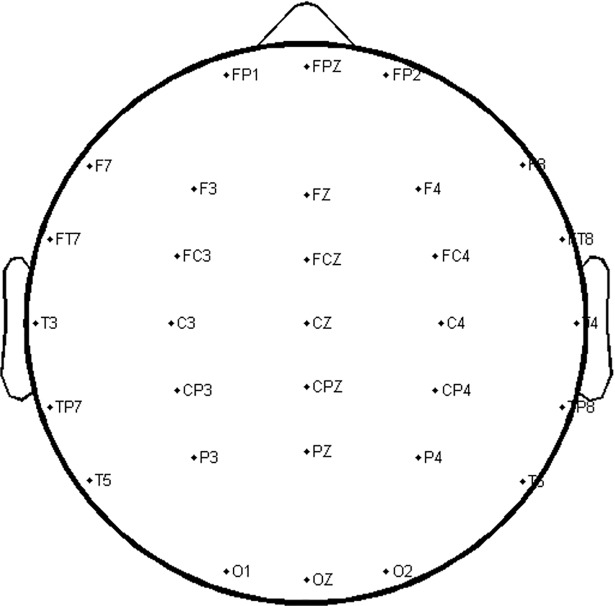
Electrode layout.